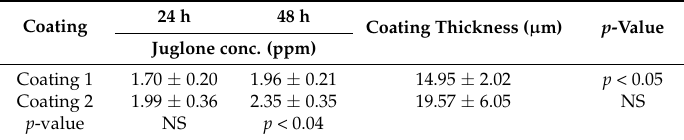
Table 1. Leaching of juglone from coated surfaces where Coating 1 = JUG + PMMA + ROS and Coating 2 = JUG + PMMA. Each coating was replicated six times ( n = 6), ± Standard deviation. Significance was assessed using one-way ANOVA. NS = Not Significant; JUG = Juglone, PMMA = poly(methyl methacrylate), ROS = Rosin. 24 h 48 h Coating Coating Thickness ( µ m) p -Value Juglone conc. (ppm)